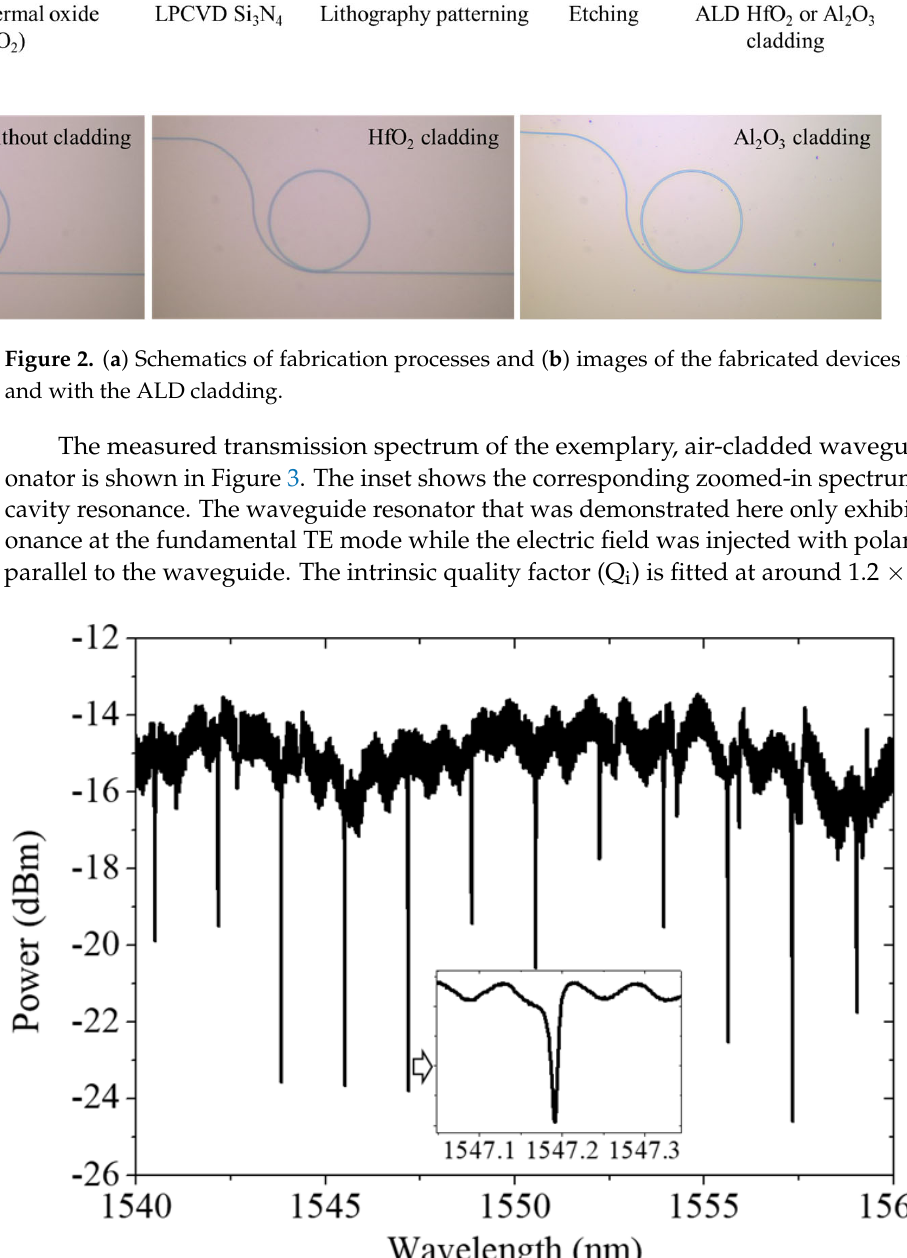
Figure 2. ( a ) Schematics of fabrication processes and ( b ) images of the fabricated devices without and with the ALD cladding.